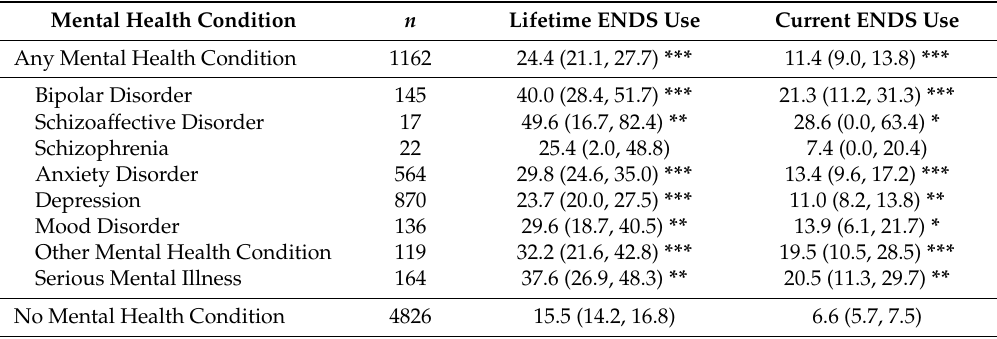
Table 4. Prevalence of lifetime and current use of Electronic Nicotine Delivery Systems (ENDS) by specific lifetime mental health